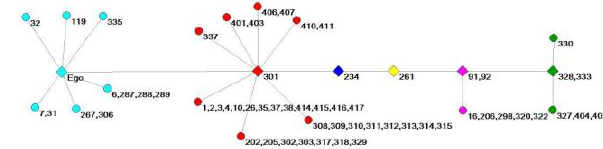
Fig.13. The tree of the deconstruction of Agnès'